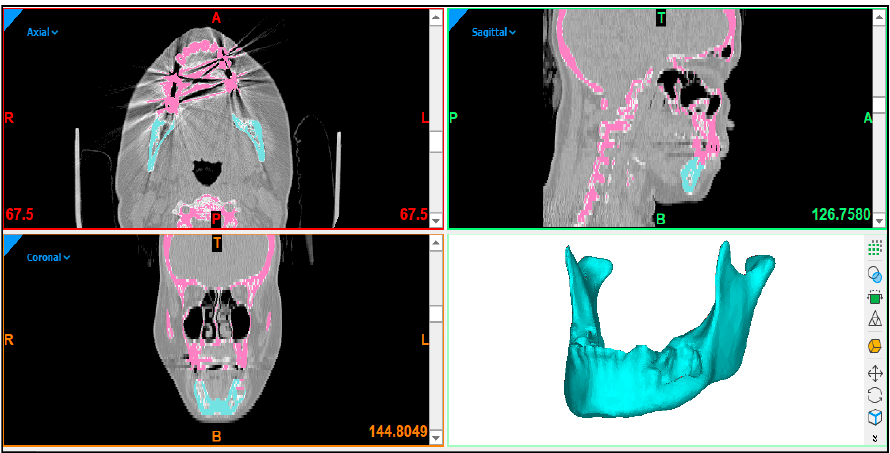
Figure 3. Segmentation of the region of interest (mandible) from the skull region.